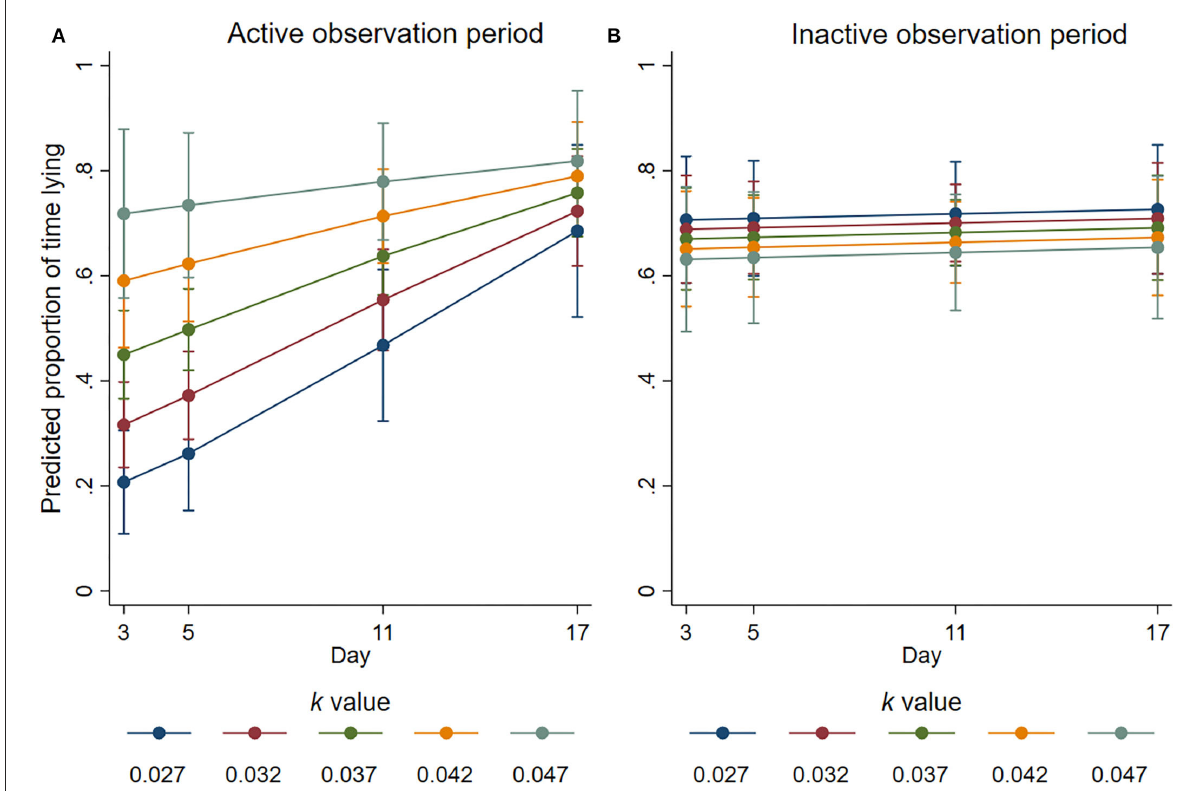
FIGURE6 Predicted proportion of time the focal animals housed at different k -values spent lying during the (A) active and (B) inactive observation periods at average values for all the other covariates. Error bars represent 95% confidence intervals of predicted mean numbers.